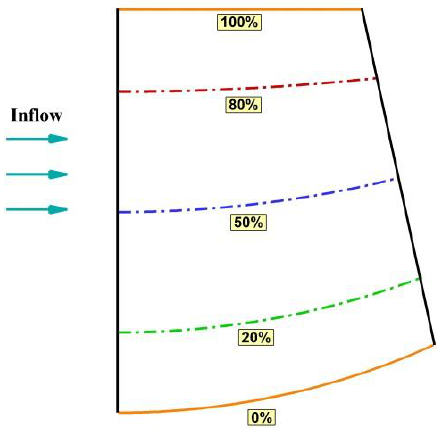
Figure 3. The blade sections of the free-formed inducer.